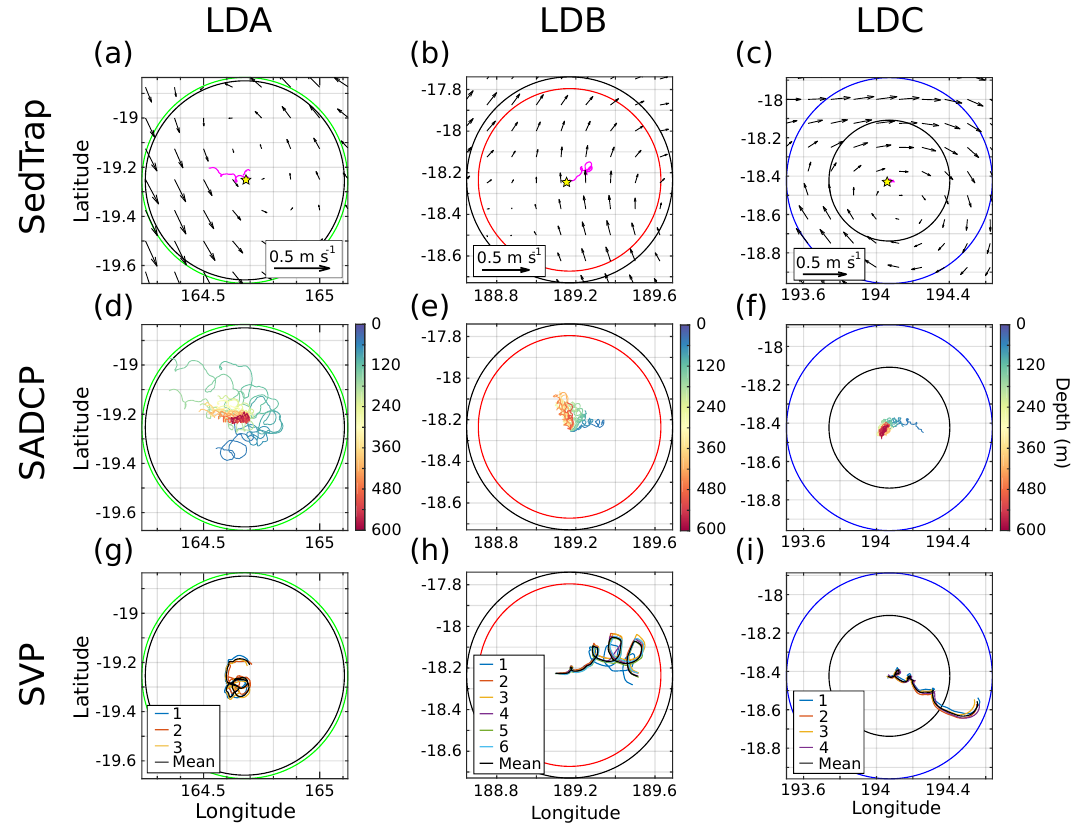
Figure 15. Observed and calculated trajectories for currents analysis. Data from LDA, LDB, and LDC, shown in left, center, and right columns, respectively. Top row (a–c) : observed trajectory of SedTrap drifter plotted in magenta. Time-averaged altimetry-derived surface currents shown with black arrows. Rossby radius R D traced as a color-coded circle, and R Z , the calculated spatial scale, in black. Starting position of SedTrap drifter shown with a star. Middle row (d–f) : calculated SADCP 38kHz trajectories of water at each depth down to 600m. Bottom row (g–i) : observed SVP drifter trajectories, with mean trajectory plotted in